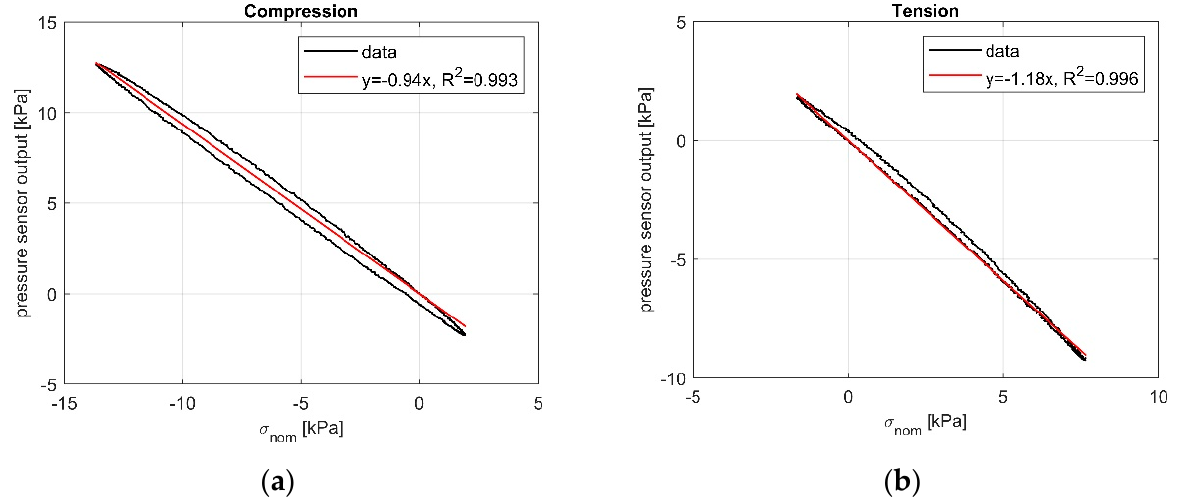
Figure 9. Uniaxial cyclic pressure sensor tests: ( a ) Compression. ( b ) Tension.